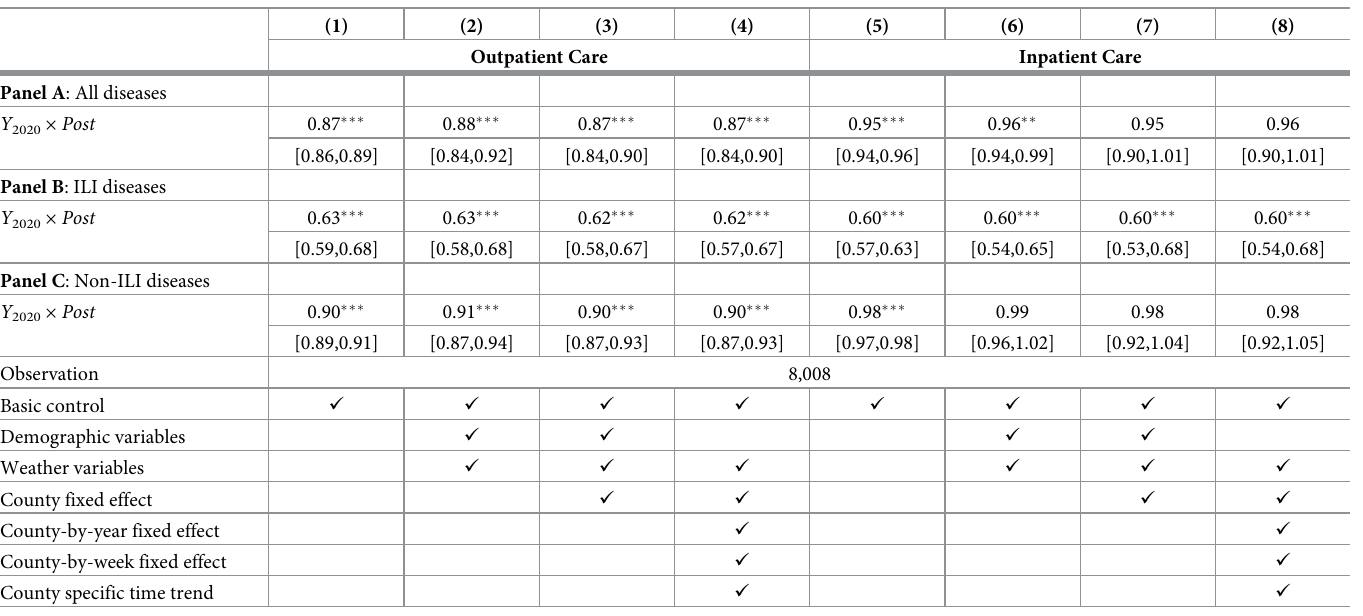
Table 2. Effects of the COVID-19 outbreak on non-COVID-19 health